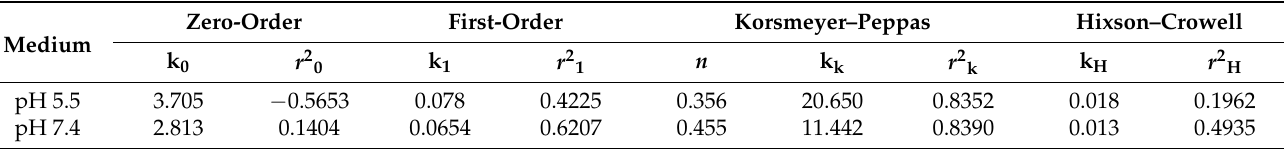
Table 1. Comparison of release kinetics model of TO from CS/Alg-NCs in different